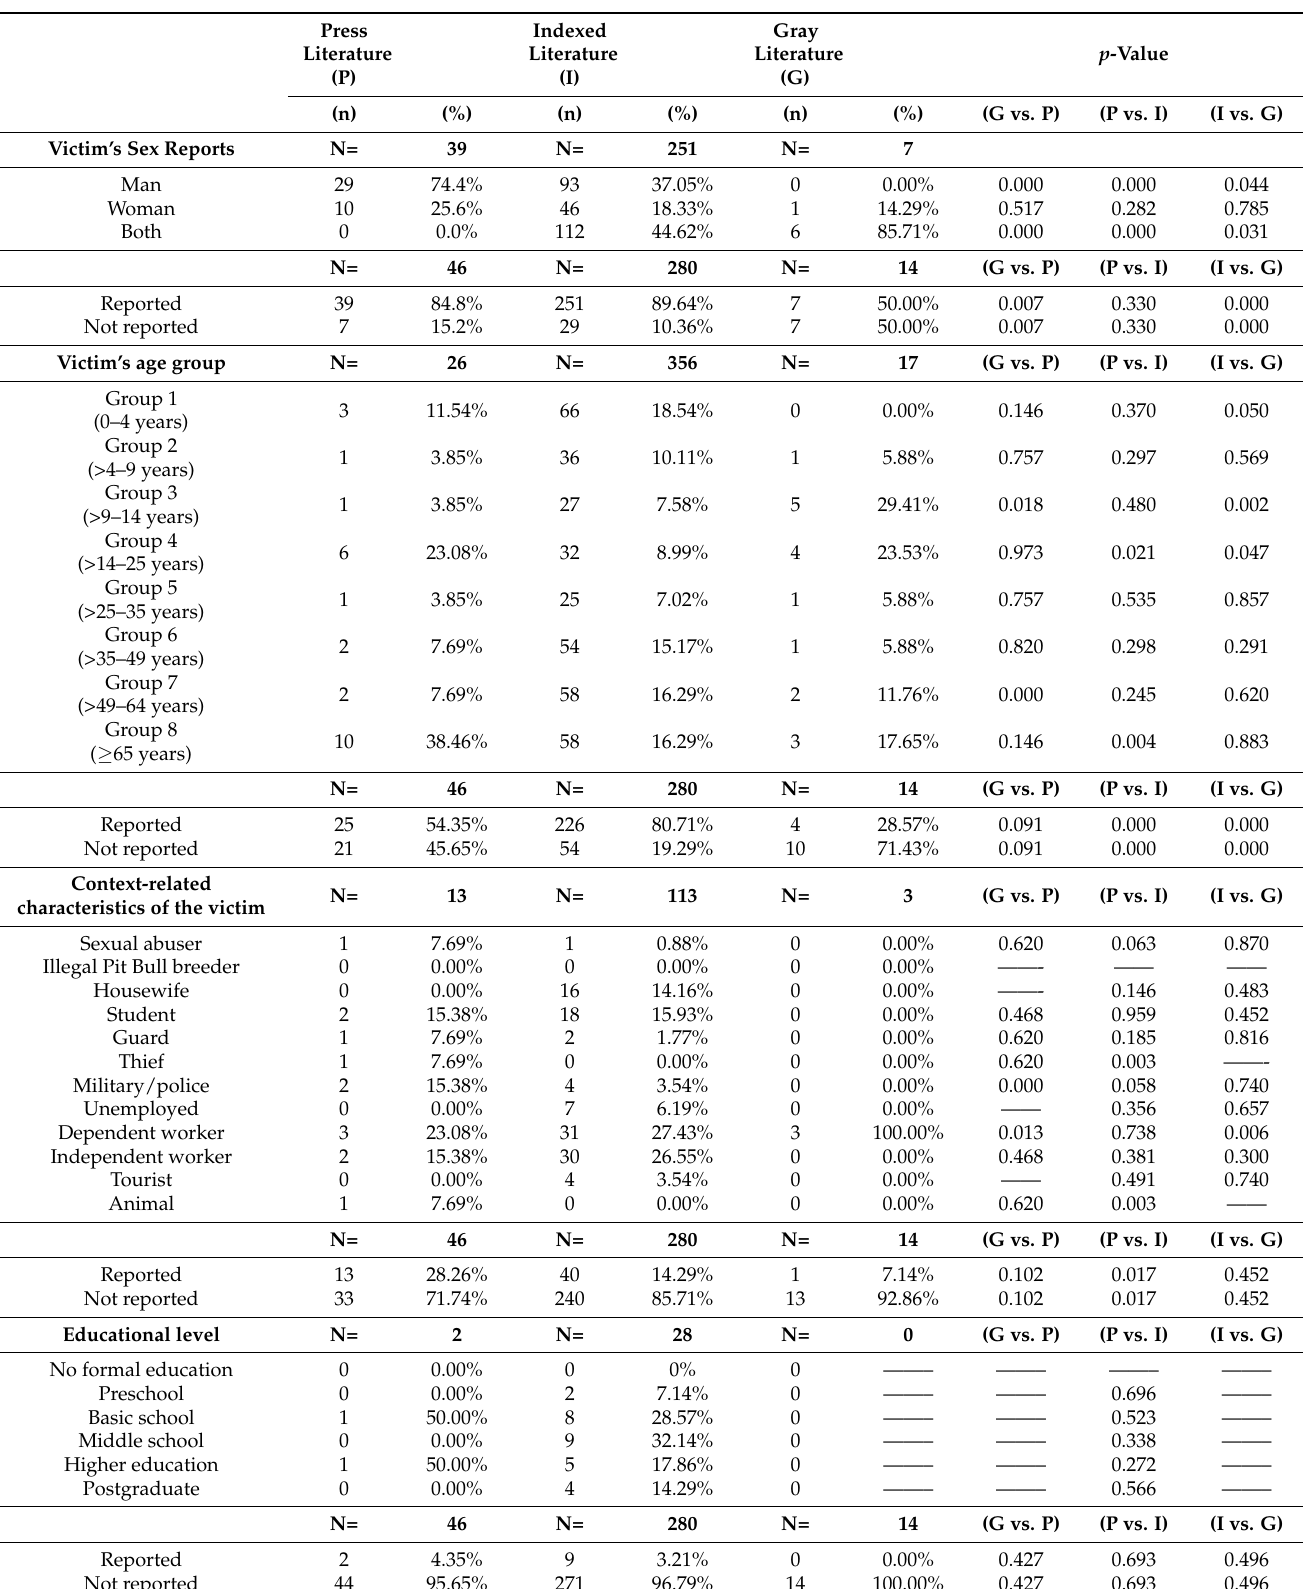
Table 4. Frequency of records that contain information about the person bitten in incidents of canine attacks in the Chilean written press, indexed and gray